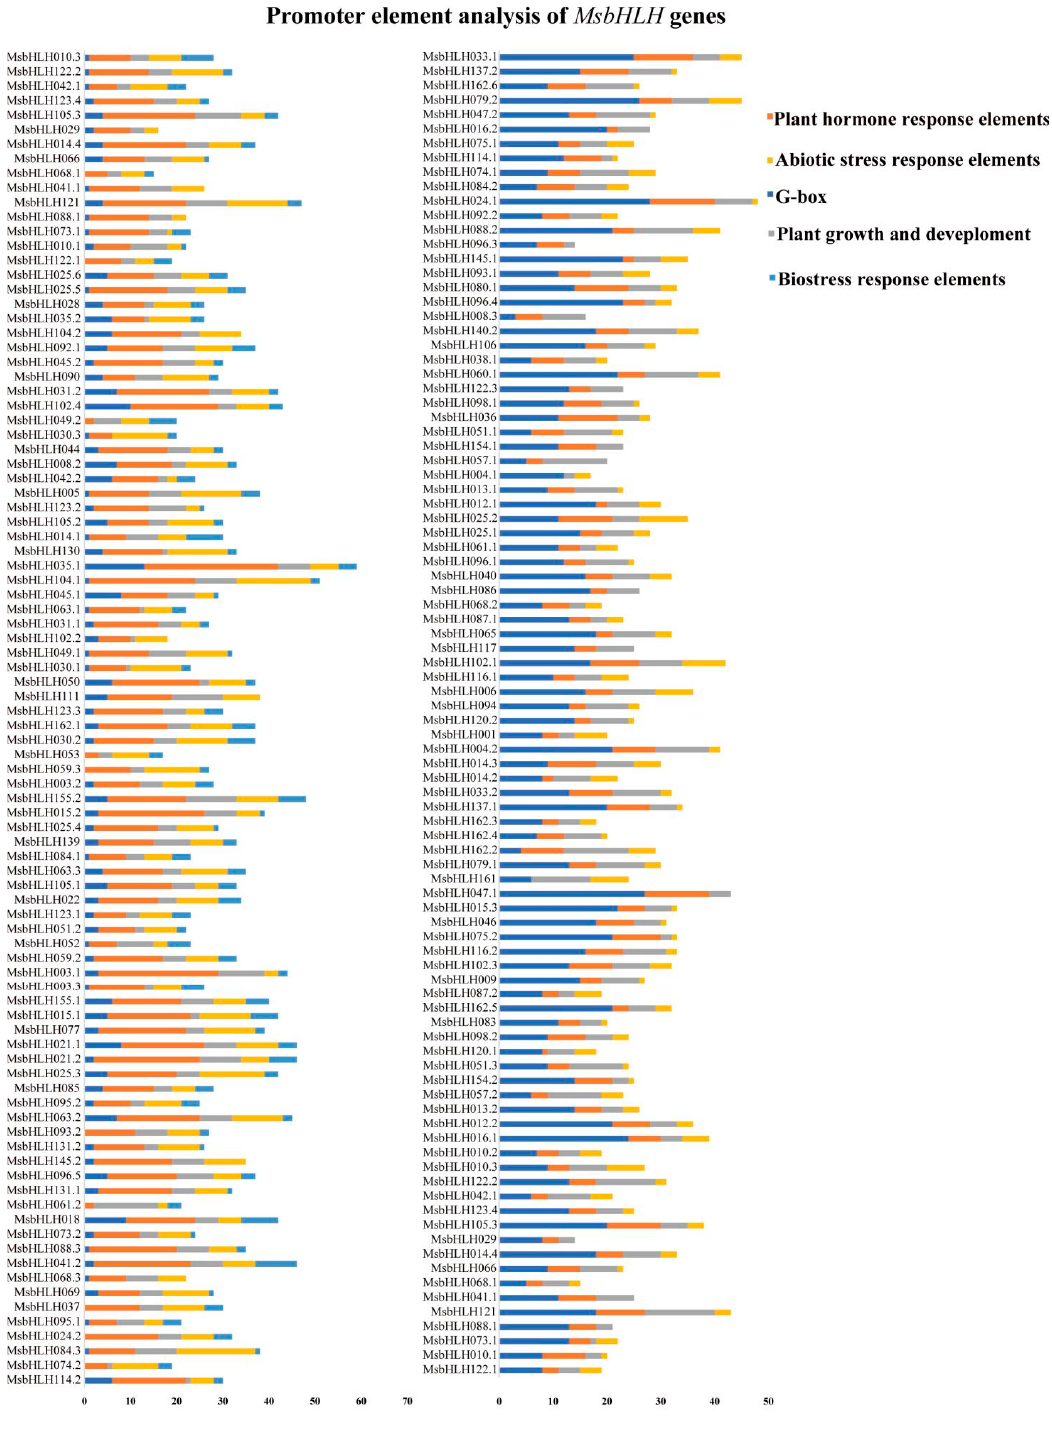
Figure 5. Cis -element analysis of 184 MsbHLH gene promoters. PlantCARE predicted the potential cis-regulatory elements in the 2000 bp promoter region upstream of M. sieversii . Different colors imply elements related to G-box, growth (circadian rhythm control), plant hormones (abscisic acid, auxin, methyl jasmonate, gibberellin, and salicylic acid), biotic stress response (insect pest and plant disease), and abiotic stress (anaerobic induction, low temperature, and drought induction).